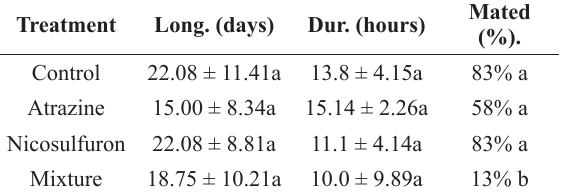
Number of females (No.), longevity (Long. (days)), duration of copulation (Dur. (hours) (day ± standard deviation) and number of females mated in 24 hours (Mated (%)) of Podisus nigrispinus (Hemiptera: Pentatomidae) exposed to atrazine and nicosulfuron. Treatment Long. (days) Dur. (hours)